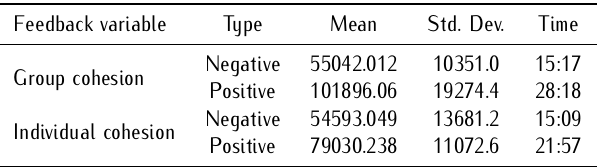
Table 11. Pacing mean comparison between positive and negative feedback on Group cohesion and Individual cohesion